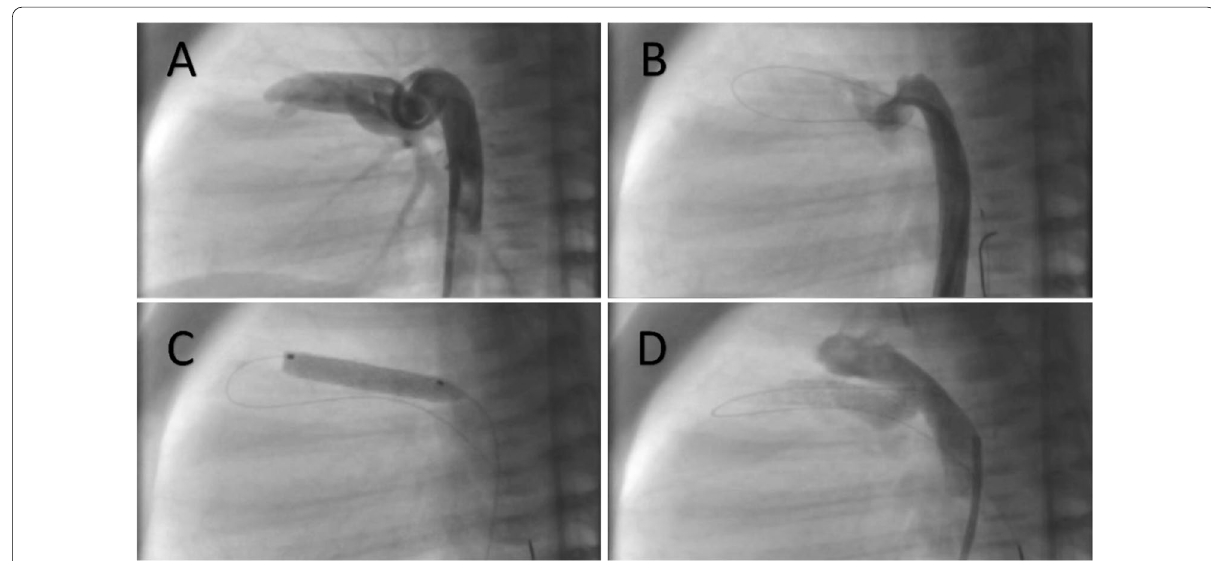
Fig. 6 Stenting a tortuous duct. ( A ) Angiography showing a tortuous duct. The wire was pushed to the pulmonary artery stump then reflected to one of the pulmonary branches ( B ) to straighten the duct and stent it safely ( C – D